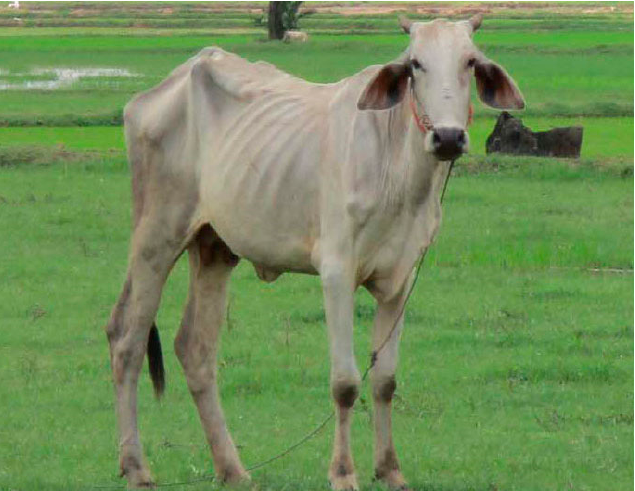
Figure 4. Gaunt cow, Preak Russey, Cambodia (T.